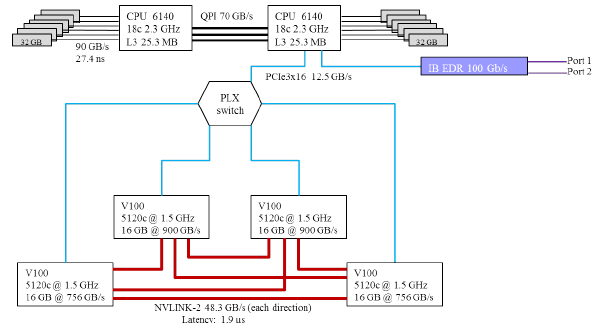
Figure 3: Principal connections between host and graphics subsys- tem on graphics nodes.